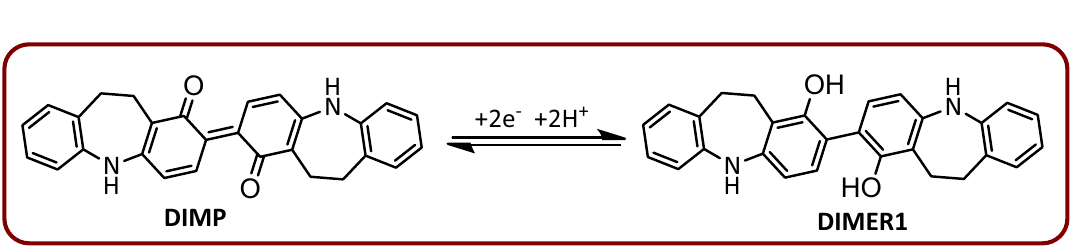
Figure 6. Cyclic voltammogram of saturated solution of synthe sized product (DIMP) in coulometric conditions, at room temperature.